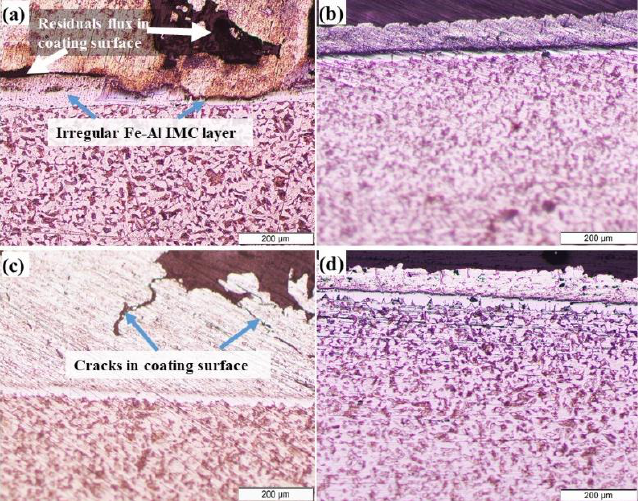
Figure 3. Cross-section microstructures of steel with Al alloy coating; ( a ) steel with flux pre-treatment surface and dipping time for 60 s; ( b ) steel with Sn pre-treatment surface and dipping time for 60 s, ( c ) steel with flux pre-treatment surface and dipping time for 210 s; ( d ) steel with Sn pre-treatment surface and dipping time for 210 s.